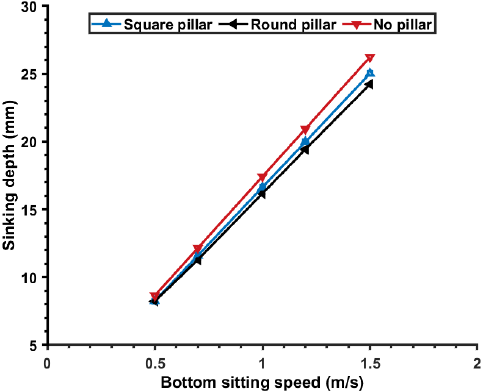
( c ) Figure 9. Simplified model diagram of the three frames: ( a ) simplified model diagram of a square pillar support frame; ( b ) simplified model diagram of a circular pillar support frame; ( c ) simplified model diagram of a plane frame. The frame is set to collide with the sediment at initial speeds of 0.5 m/s, 0.7 m/s, 1.0